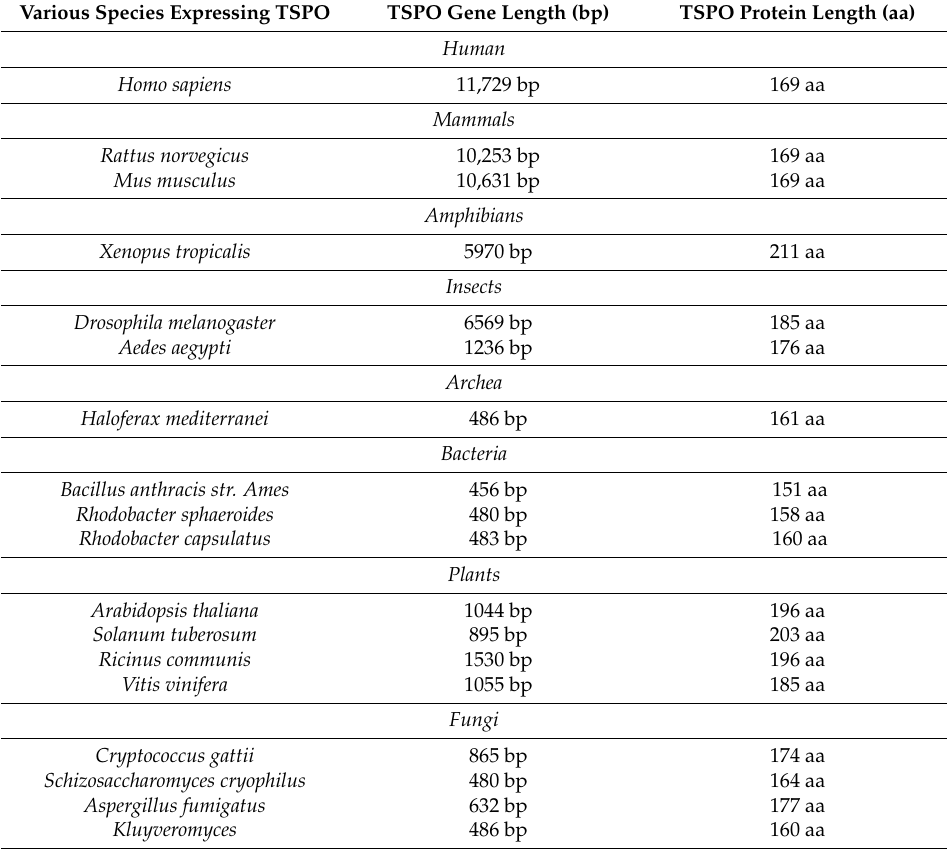
Table 1. Translocator protein (TSPO) gene length in base pairs (bp) and protein length in amino acids (aa) in different species that are discussed in this review, plus a few additional ones, to obtain a representative view of what is known regarding TSPO in living organisms in general. The left column gives the names of the species. The species are organized according to: human, mammals, insects, archea, bacteria, plants, and fungi. The middle column shows the TSPO gene lengths in base pairs (bp) for each species. The right column shows the protein lengths, which are between 151 and 211 aa. TSPO protein molecular weight for all species typically is 18 kDa. Interestingly, while protein size does not differ essentially from species to species, as shown here, gene length varies from 11,729 bp in humans to as low as 456 bp in Bacillus anthracis str. Ames . (After the resources “Gene” and “Protein” from the National Center for Biotechnology Information, National Library of Medicine, 8600 Rockville Pike, Bethesda, MD,